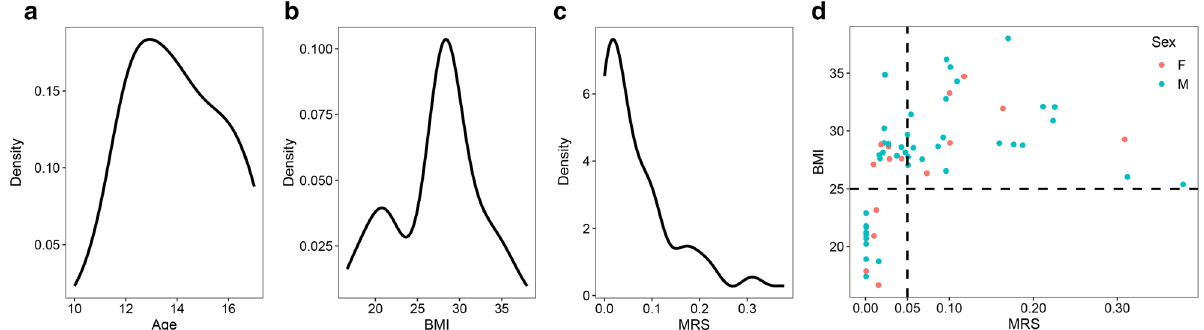
Figure 1. Phenotypes and their distribution in children. ( a ) The age ranges from 10 to 17 years, which is not normally distributed (Shapiro test, P < 0.05). ( b ) The BMI which ranges from 16.6 to 38.0, is not normally distributed (Shapiro test, P < 0.05). ( c ) The MRS-PDFF ranges from 0 to 0.38, and is not normally distributed as well (Shapiro test, P < 0.05). ( d ) The BMI of the children with NAFLD (MRS > 0.05) is > 25, and the BIM and MRS-PDFF have a significant correlation (Spearman’s rho = 0.7). Note: The dotted lines of Fig. 1A, B, C represent the mean.